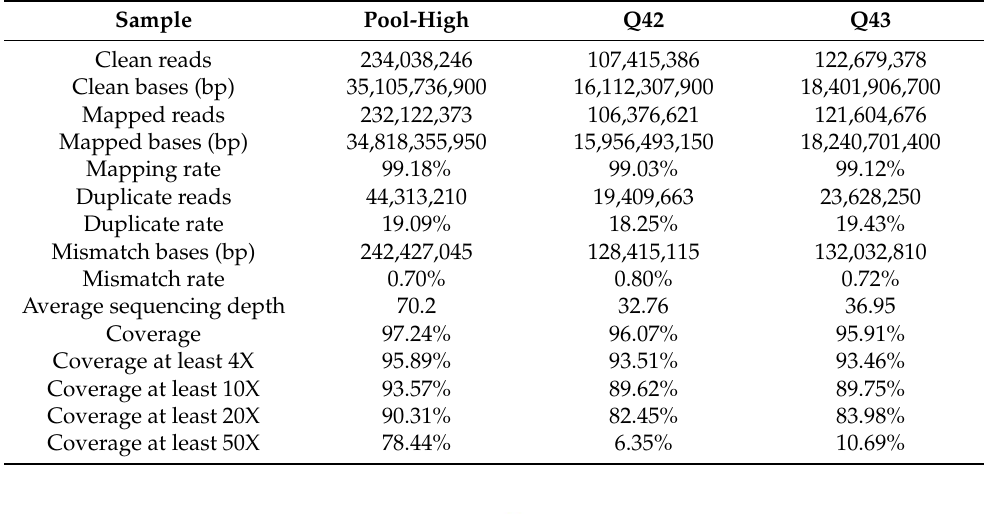
Table 3. Statistical results of sequence alignment.